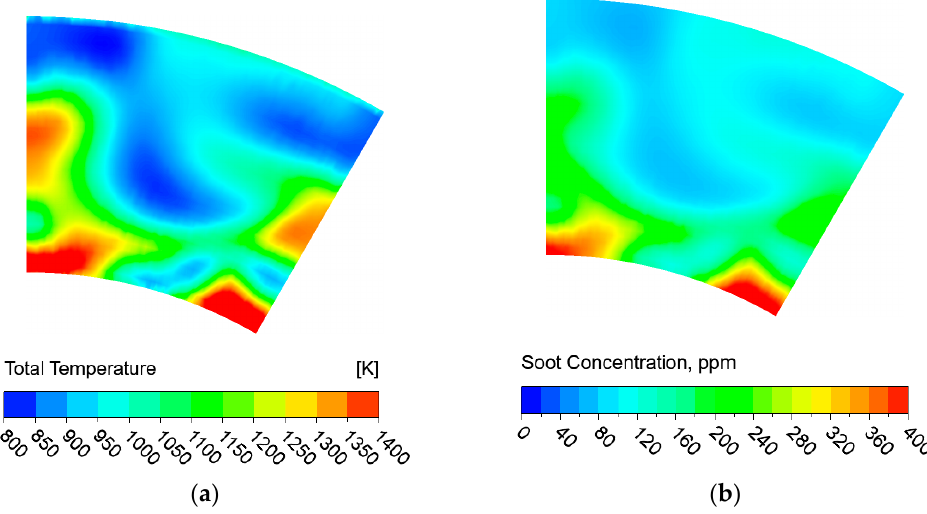
Figure 8. Combustor outlet contours: ( a ) total temperature; ( b ) soot